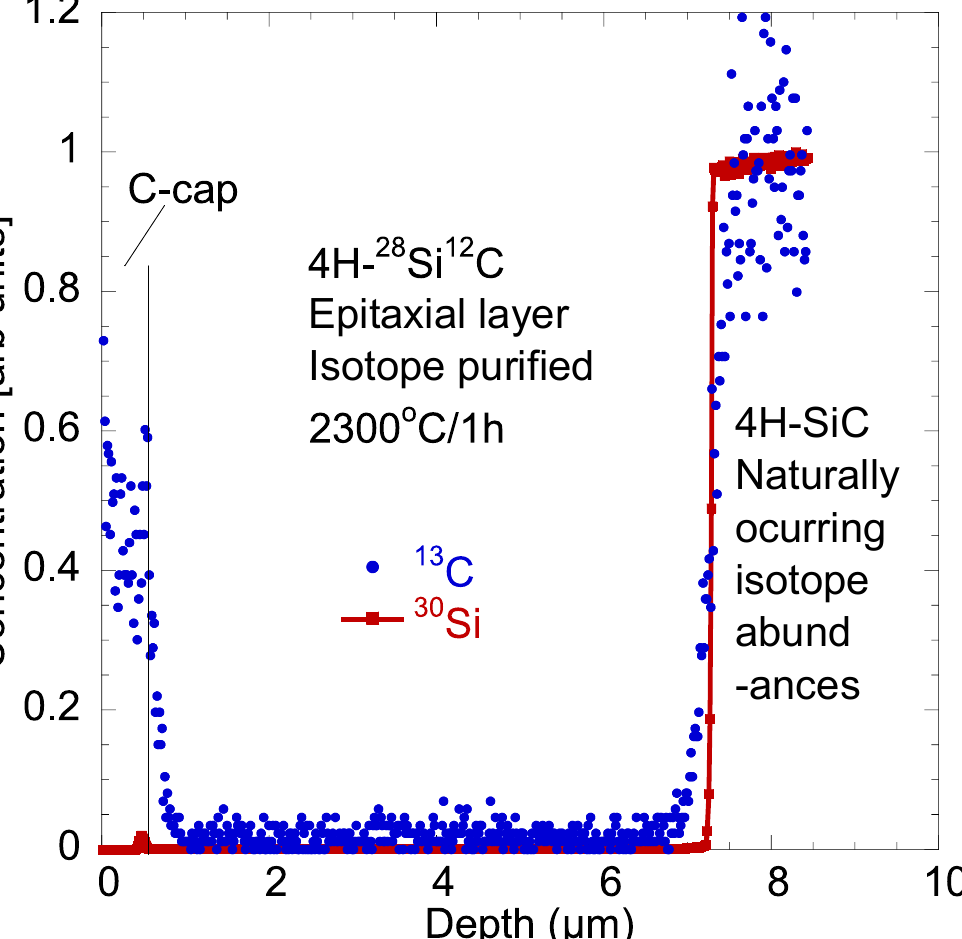
Figure 1. Overview of the sample geometry as detected by secondary ion mass spectrometry (SIMS), with 13 C concentration values normalized to 1 in the 4H-SiC substrate. Note that the sample was heated to 2300 ◦ C for 1 h.